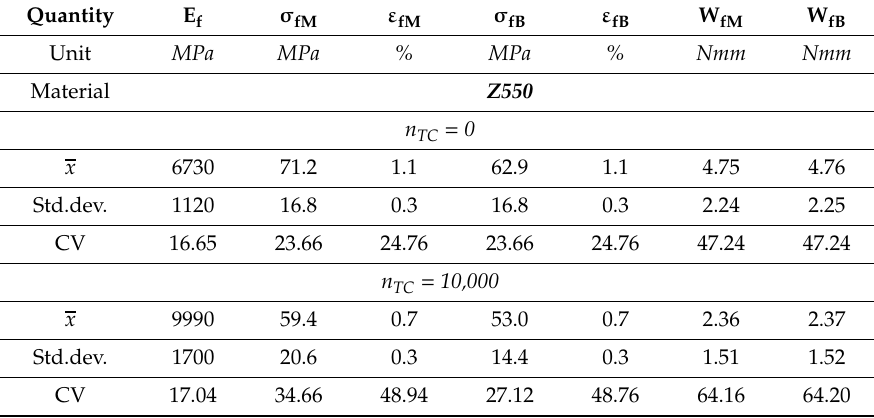
Table 3. Descriptive statistics of the results obtained in the TFS